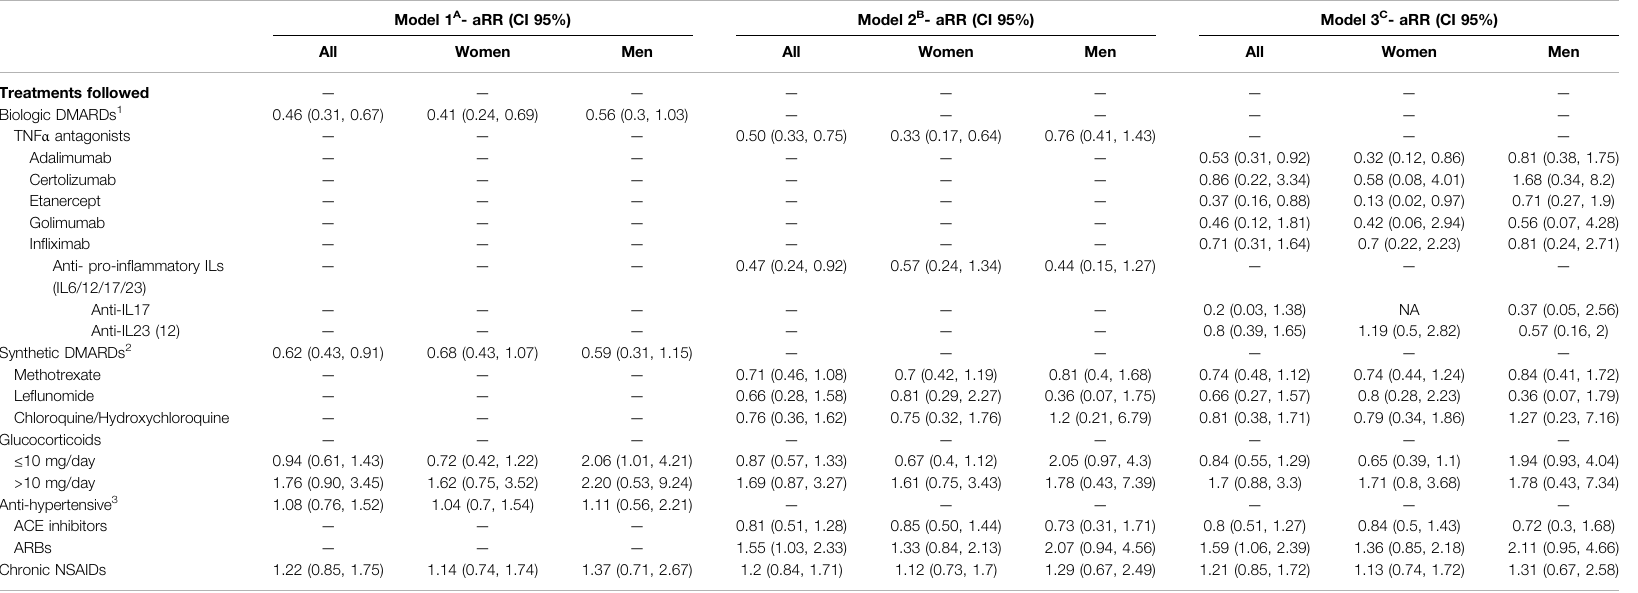
TABLE 6 | Adjusted Relative Risk* (aRR) with 95% con fi dence intervals (CI 95%) of COVID-19 according to the presence of